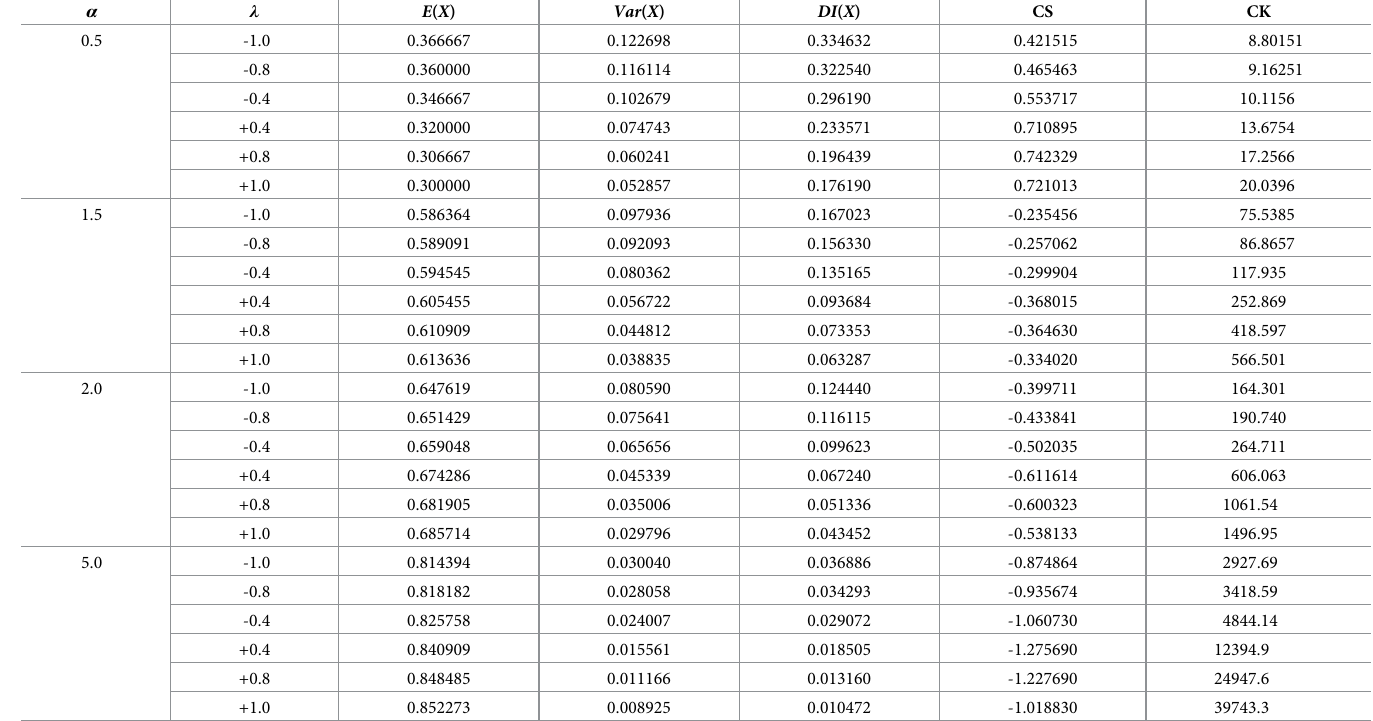
Table 1. The mean, variance, DI, CS, and CK of the NCTPF distribution for ( θ =